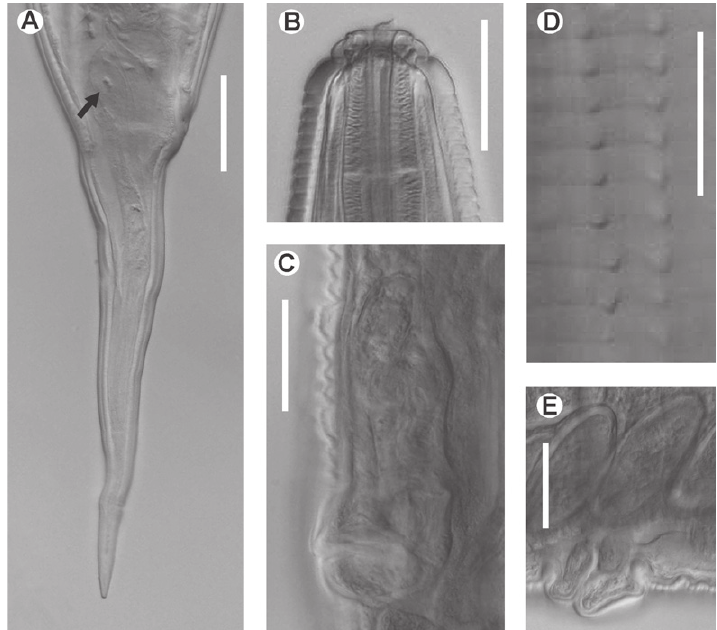
Figure 2. Hystrignathus dearmasi sp. n. female. A Tail, lateral view (arrow shows therectal glands) B Cephalic region and stoma C Vulva, ventro-lateral view D Cervical spines E Prominent lips of the vulva, lateral view. Scale bars: A, B, C, E. 0.05 mm; D. 0.025